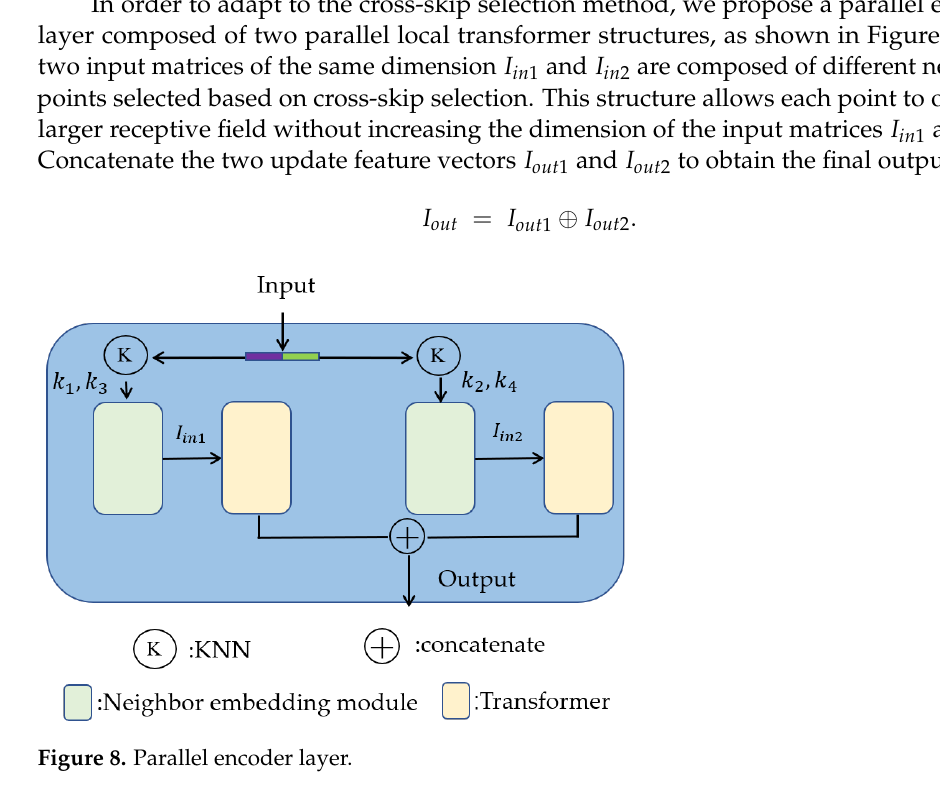
Figure 7. Junction of multiple objects.